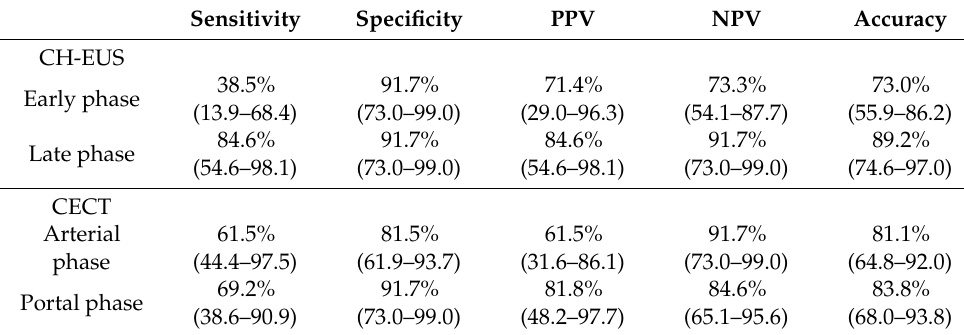
Table 4. Diagnostic value of CH-EUS and CECT for aggressive PanNENs.